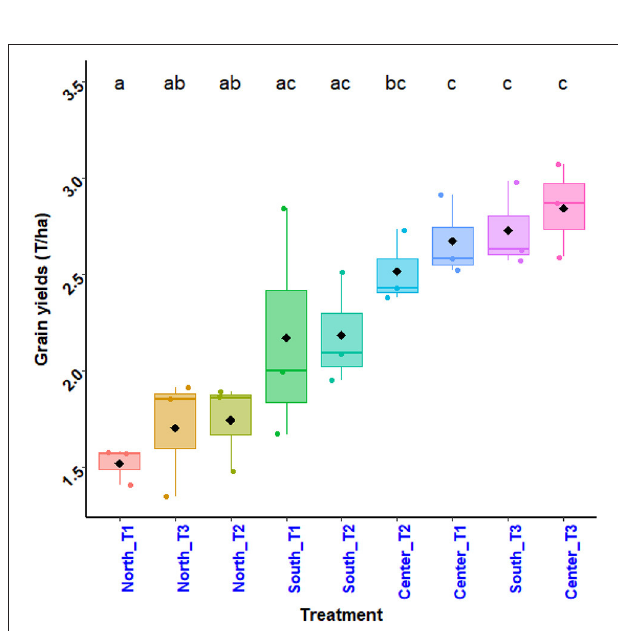
FIGURE 5 | Corn grain yield variation by